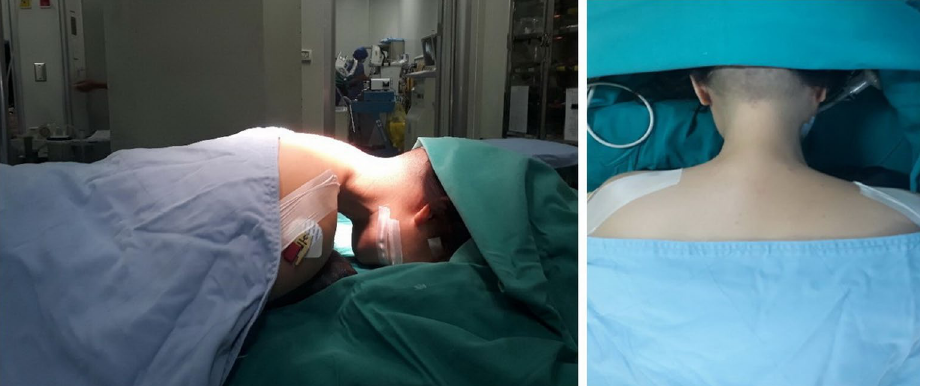
Figure 1. The position of a patient during surgery.